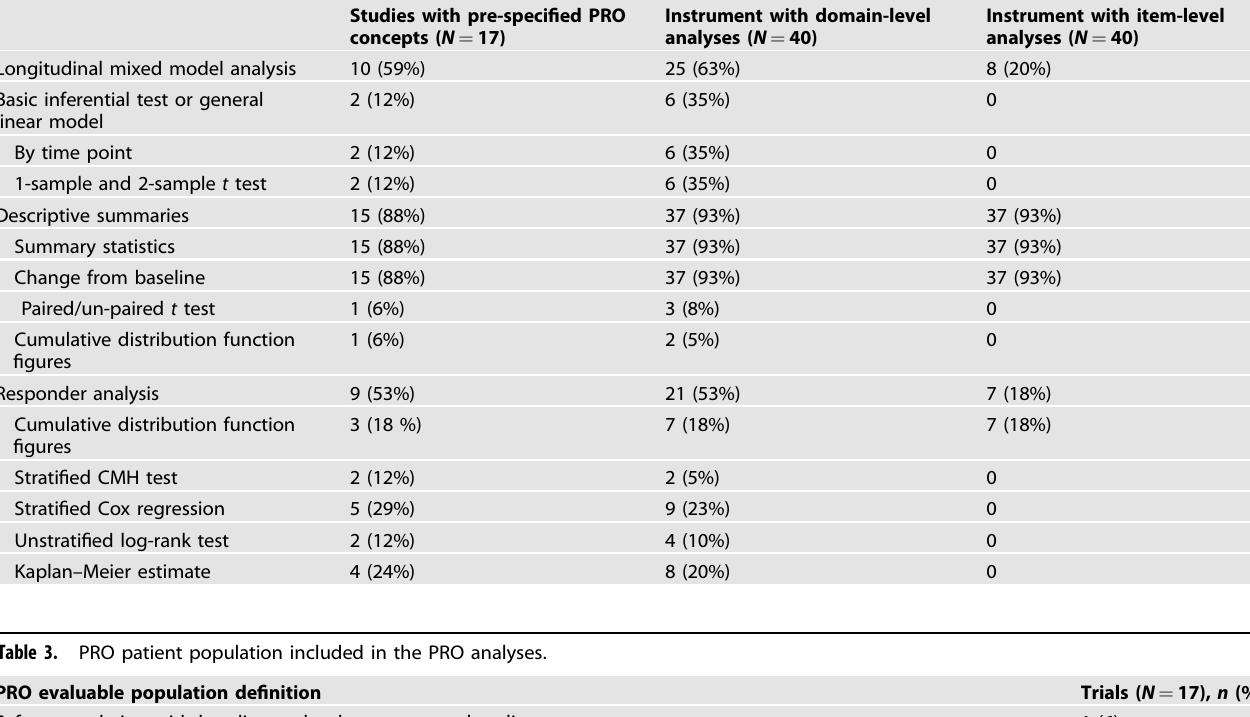
Table 2. Statistical analysis of pre-speci fi ed PRO in the SAP concepts, domain, and single items of the 17 trials reviewed. Studies with pre-speci fi ed PRO Instrument with domain-level concepts ( N = 17) analyses ( N = 40)